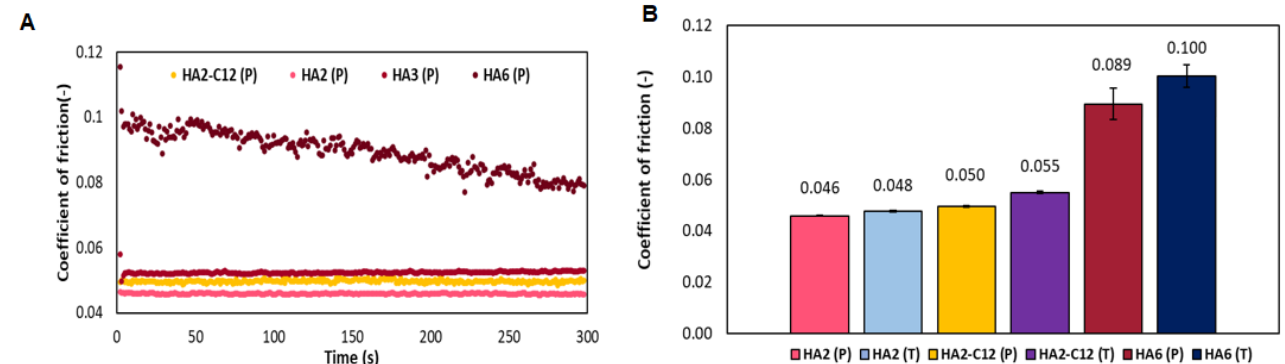
Figure 5. ( A ) Development of friction coefficient for HA and HA2-C12 as a function of time ( B ) Average coefficient of friction of HA and HA2-C12 samples in saline buffer (P). ( B ) Comparison of coefficient of friction for native HA and HA2-C12 in saline (P) or trehalose (T) buffers, respectively.